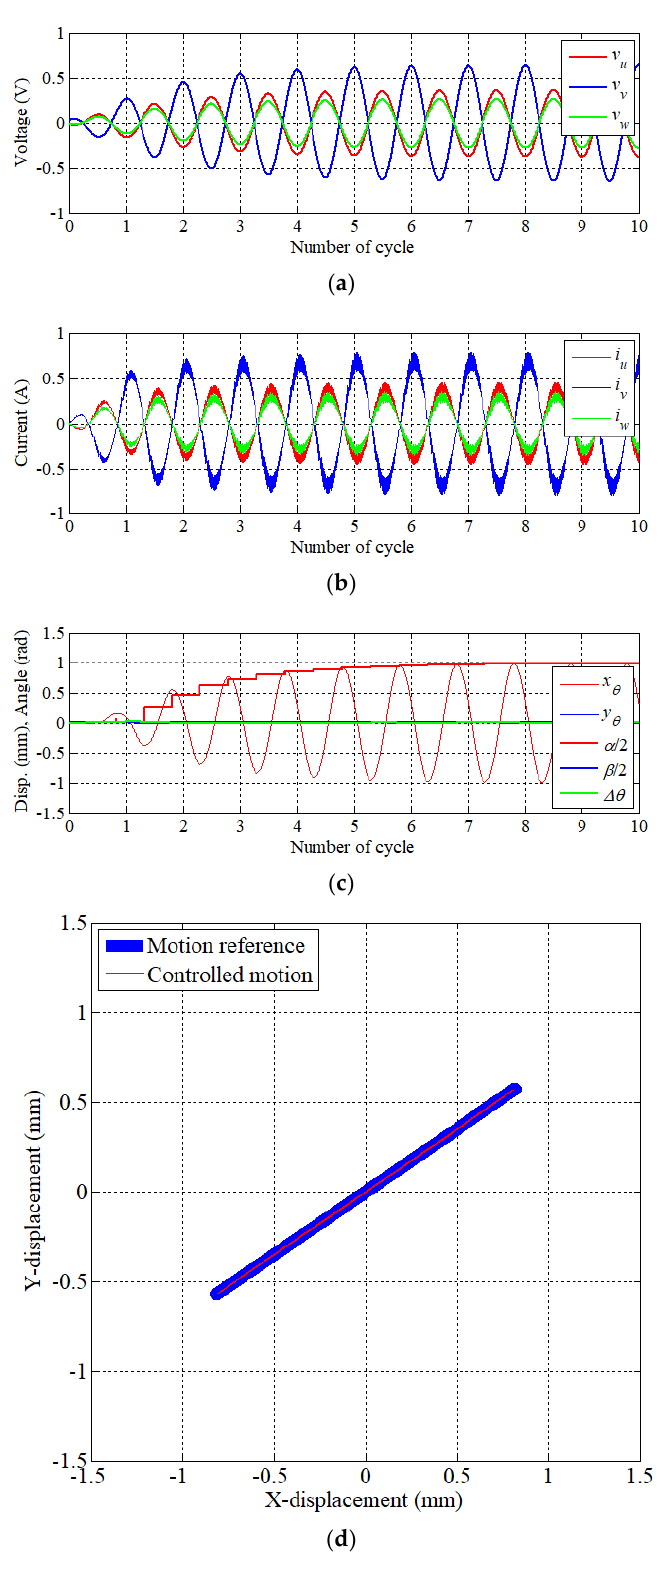
Figure 14. Result of reciprocating motion ( α : 2 mm, β : 0 mm, θ : 35 deg.) ( a ) Phase voltage reference, ( b ) phase current, ( c ) displacement, and ( d ) trajectory of motion.